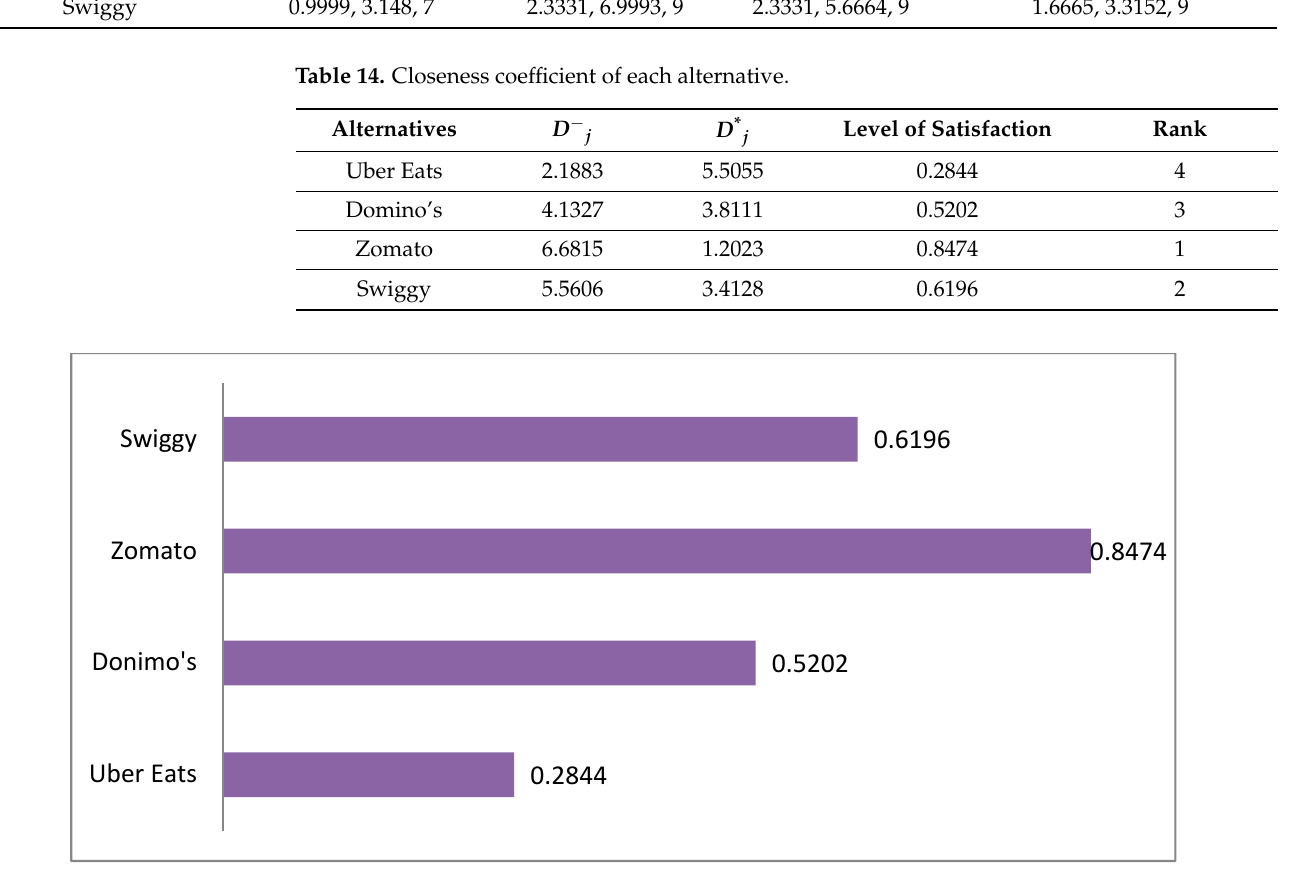
Figure 6. Score line of the FTOPSIS model.